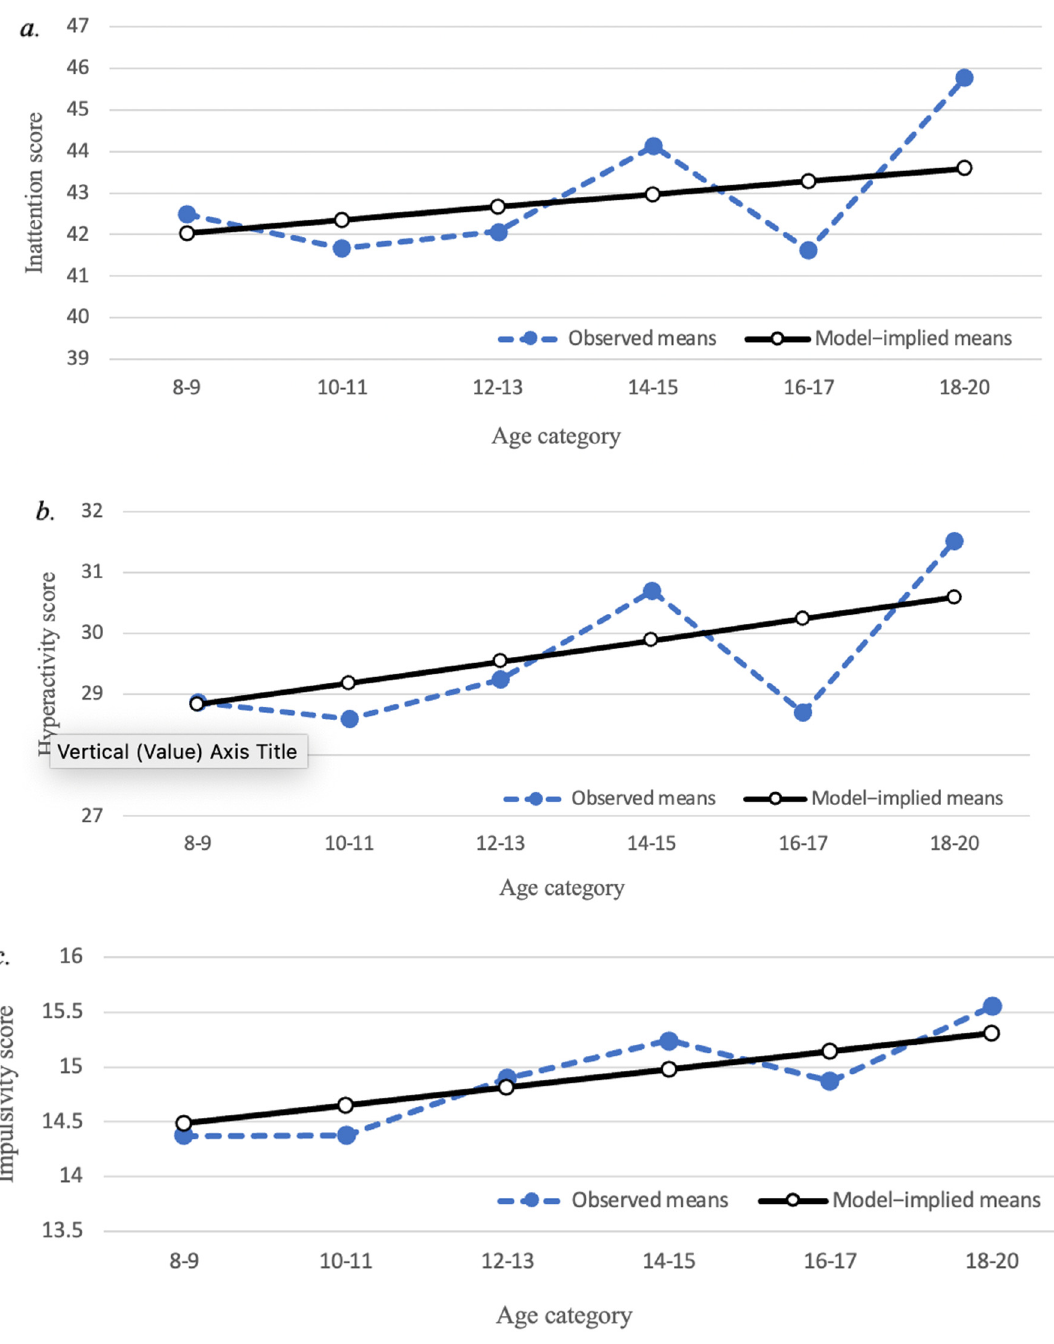
Figure 2. Developmental trajectories of SWAN subscale scores. ( a ) Trajectory of inattention scores; ( b ) Trajectory of hyperactivity scores; ( c ) Trajectory of impulsivity scores. Closed circles represent observed means; open circles represent model-implied